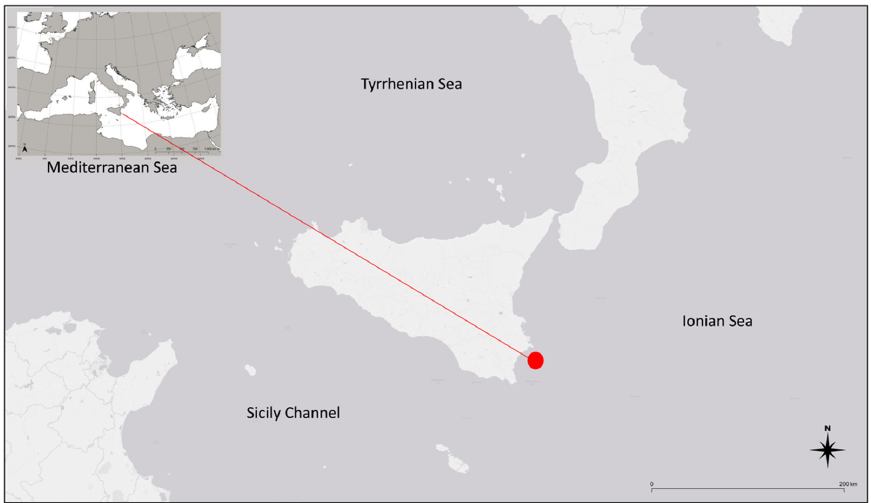
Figure 1. Capture site of Z. cristatus (36°50 ′ 05 ″ N 15°16 ′ 49 ″ E). Figure obtained with GIS software [64].